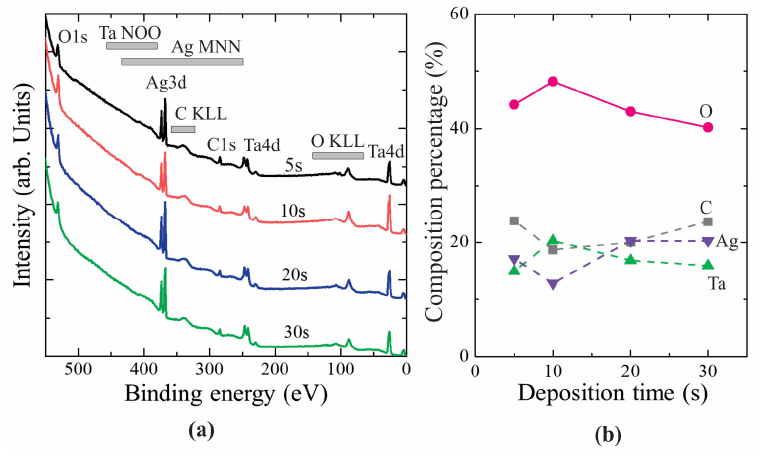
6 of 11 Figure 4. UPS spectra of prepared Ag–Ta thin films at different deposition times: ( a ) high-energy and ( b ) low-energy cut-off point. Table 1. Work function and C1s C–C reference binding energy of prepared Ag–Ta thin films at different deposition times. Deposition Time (s)